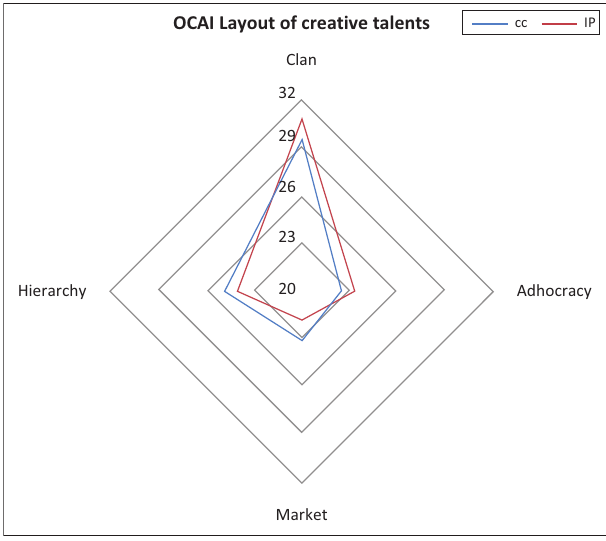
FIGURE 2: Organisational culture cognition difference of general TABLE 1: Descriptive statistics.